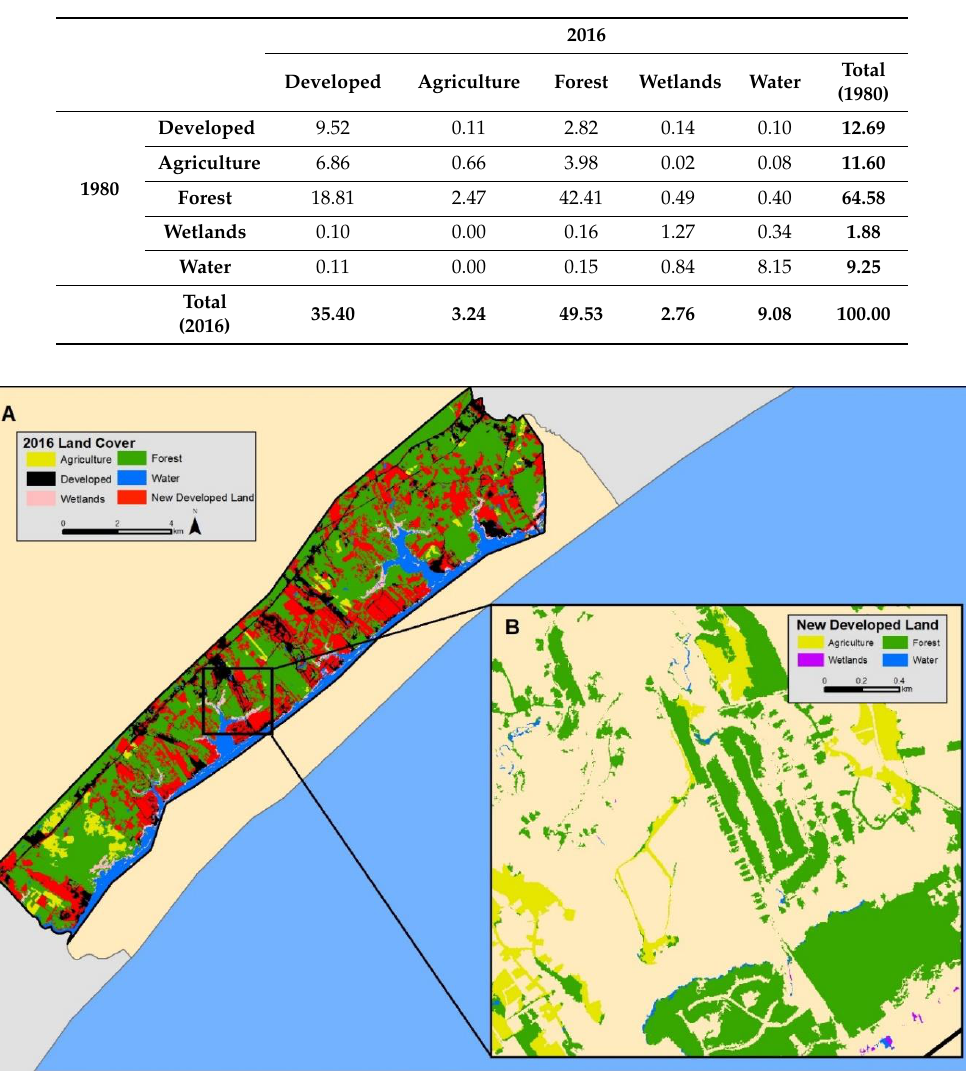
Table 6. Land Cover Change Matrix (in percent) for Coastal Pender County: 1980–2016. (Data source: NAIP).